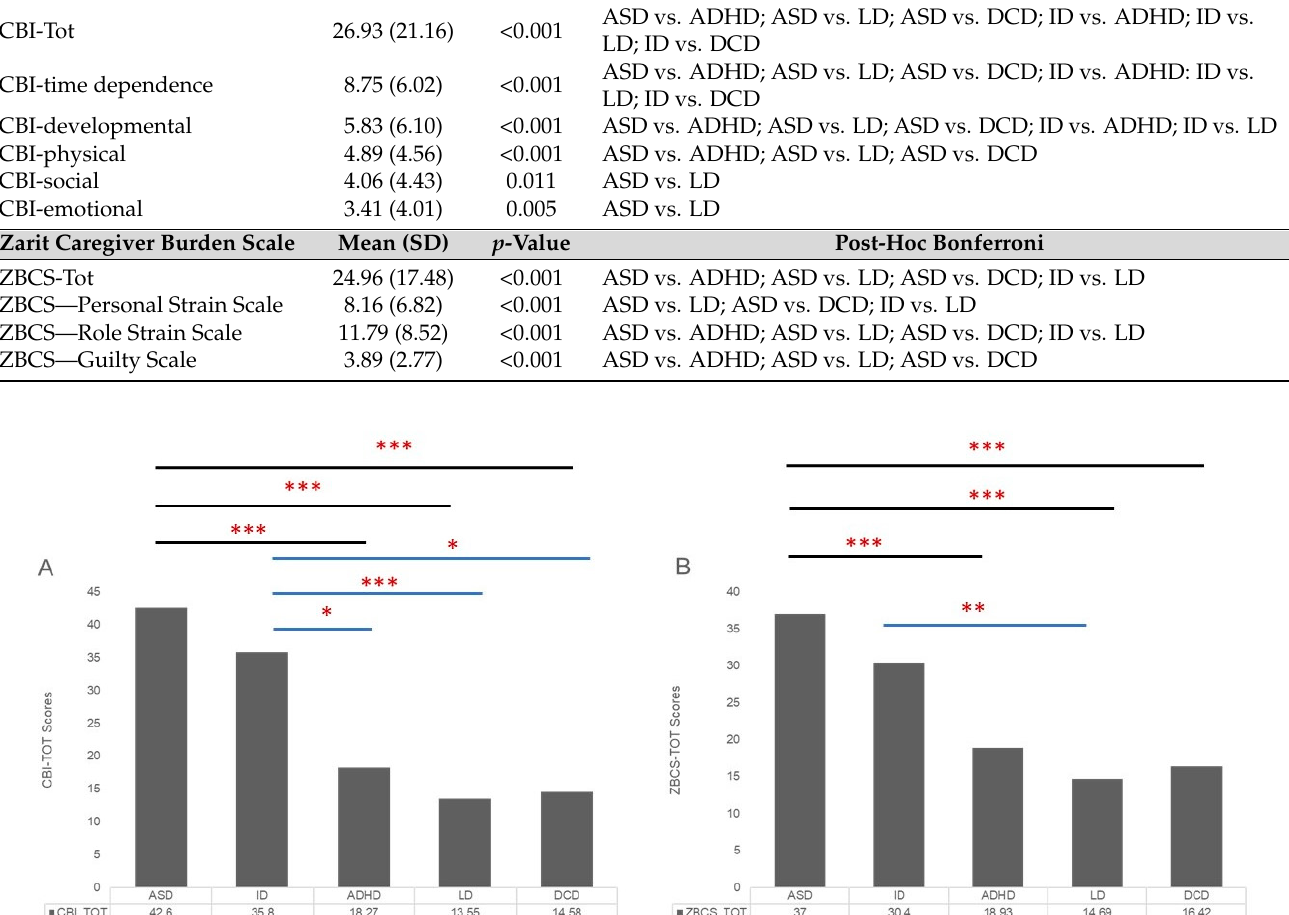
Figure 2. Graphic representation of means of scores (( A ) Caregiver Burden Inventory—Total Scores; ( B ) Zarit Caregiver Burden Scale—Total Scores) in the caregiver’s groups. The asterisks indicate a significant difference between conditions: * p ≤ 0.05, ** p ≤ 0.01, *** p ≤ 0.005. (ASD: Autism Spectrum Disorder; ID: Intellectual Disability; ADHD: